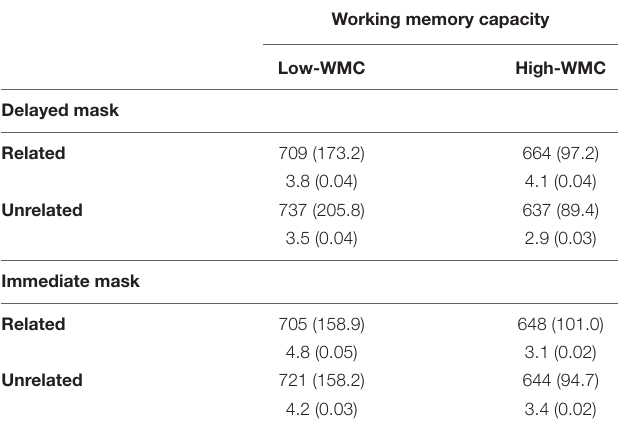
TABLE 2 | Mean (SD) reaction times (in milliseconds), and error percentages (in %) as a function of working memory capacity (Low vs. High WMC), Prime-Target Relatedness (related vs. unrelated) and masking condition (delayed vs. immediate